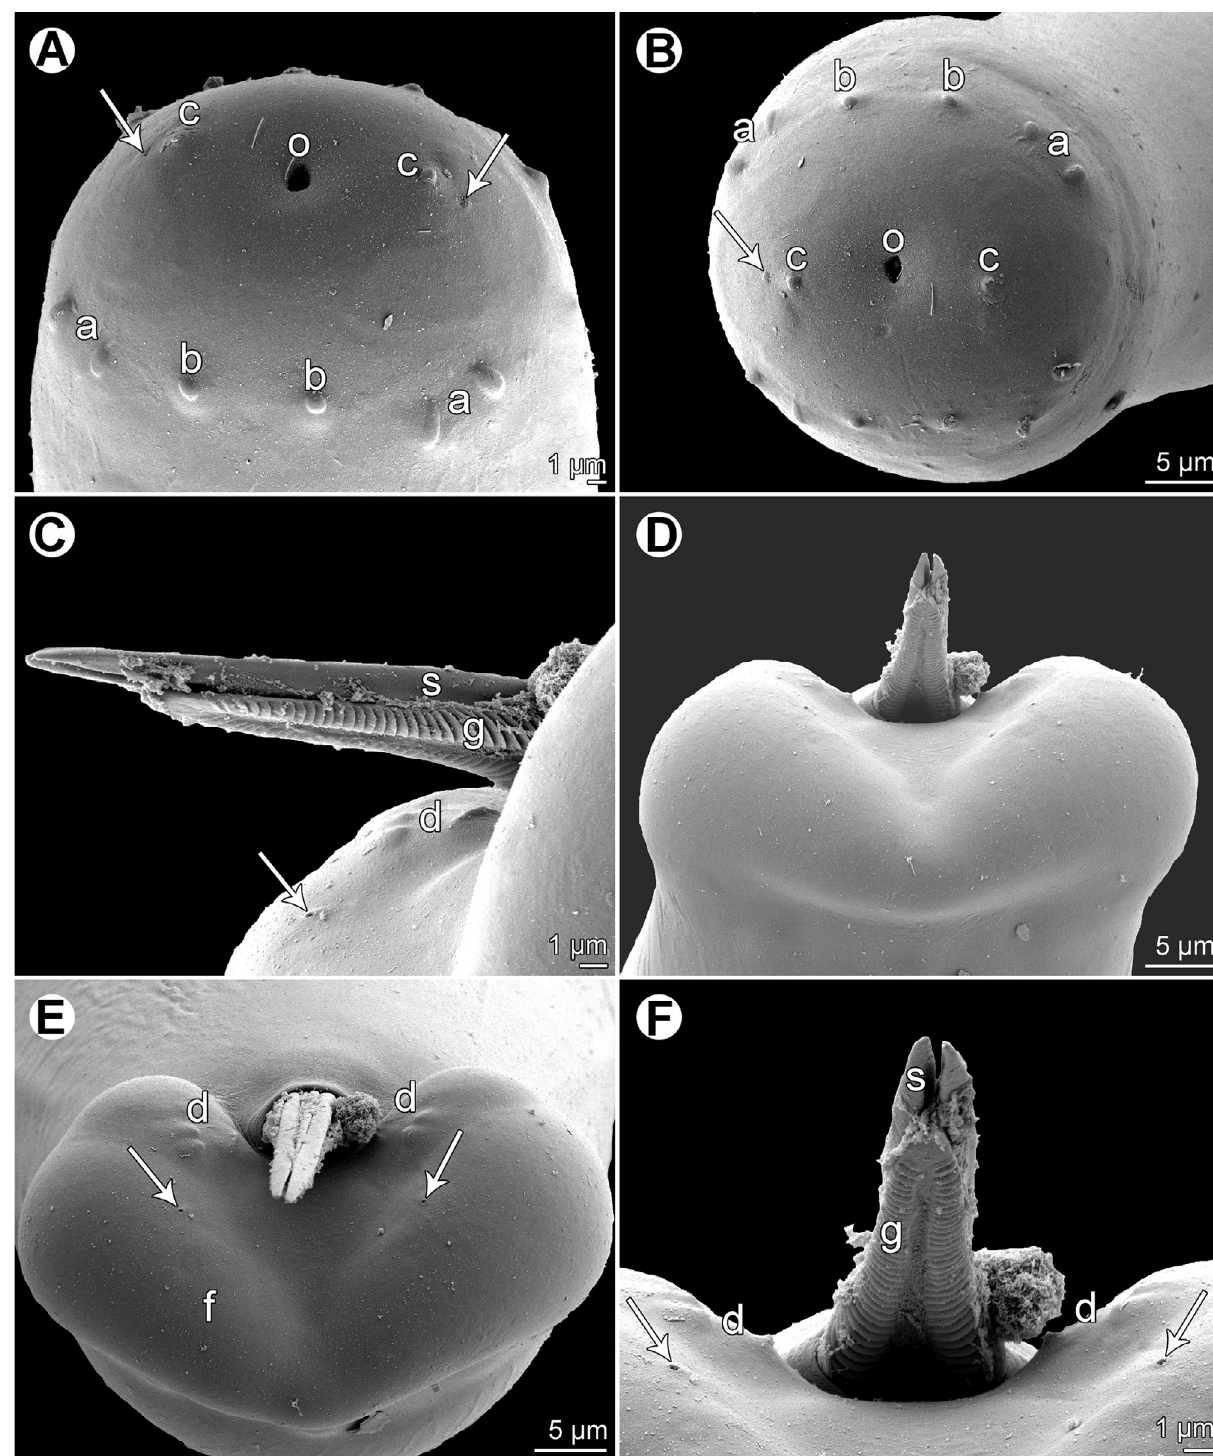
Figure 4. Philometra piscaria n. sp. from Epinephelus coioides , scanning electron micrographs of male. A, B: Cephalic end, subapical and apical views (arrows indicate amphids). C: Distal ends of gubernaculum and spicules, lateral view (arrow indicates phasmid). D, E: Caudal end, dorsal and apical views, respectively (arrows indicate phasmids). F: Region of cloacal aperture, dorsal view (arrows indicate phasmids). Abbreviations : a, submedian pair of cephalic papillae of external circle; b, submedian cephalic papilla of internal circle; c, lateral cephalic papilla of internal circle; d, group of three caudal papillae near cloacal aperture; f, caudal mound; g, gubernaculum; o, oral aperture; s,